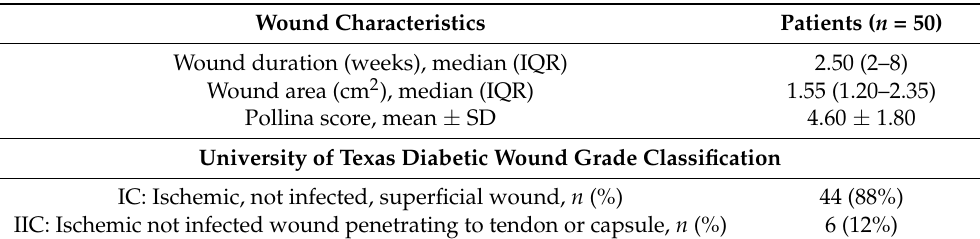
Table 2. Wound characteristics of patients at